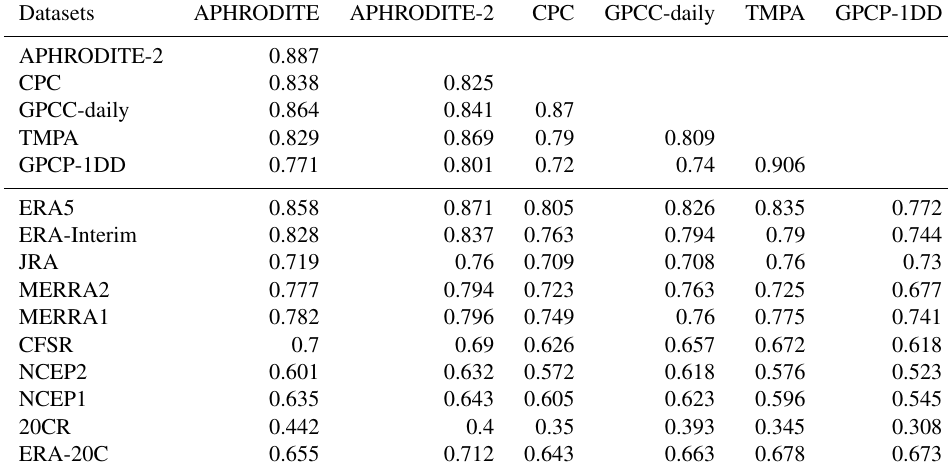
Table 7. Same as Table 6 for the lower